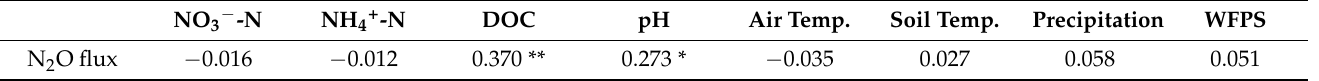
Table 2. Pearson correlation of daily N 2 O flux rate with environmental variables.